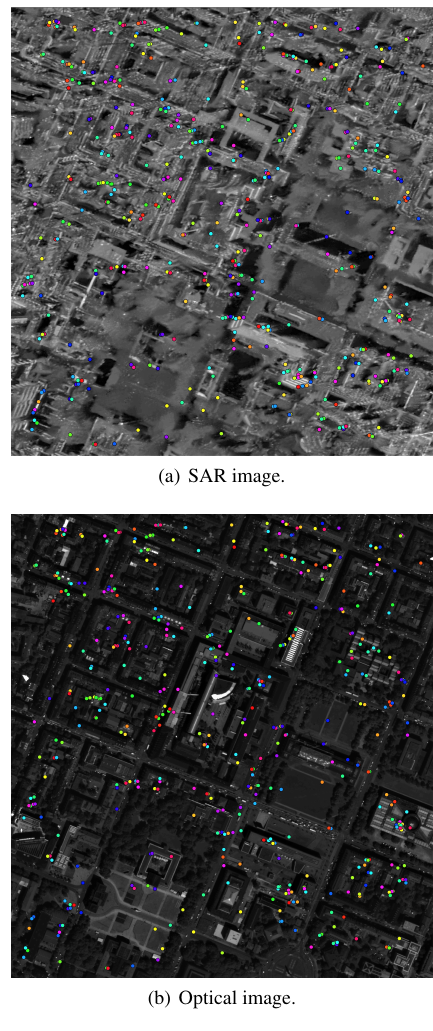
Figure 4. Tie points matching result for the whole study area (Number of tie points: 471).